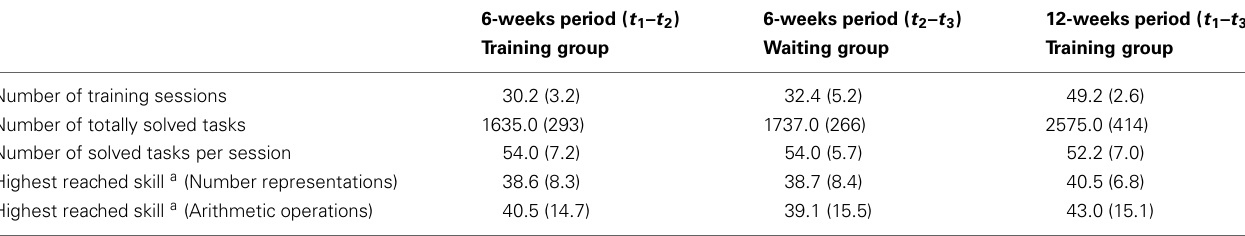
a The skills of the adaptive model are divided into the content areas of the training program (section Adaptive algorithm). Skills in each area are ordered by their number, with the easiest skill having the lowest